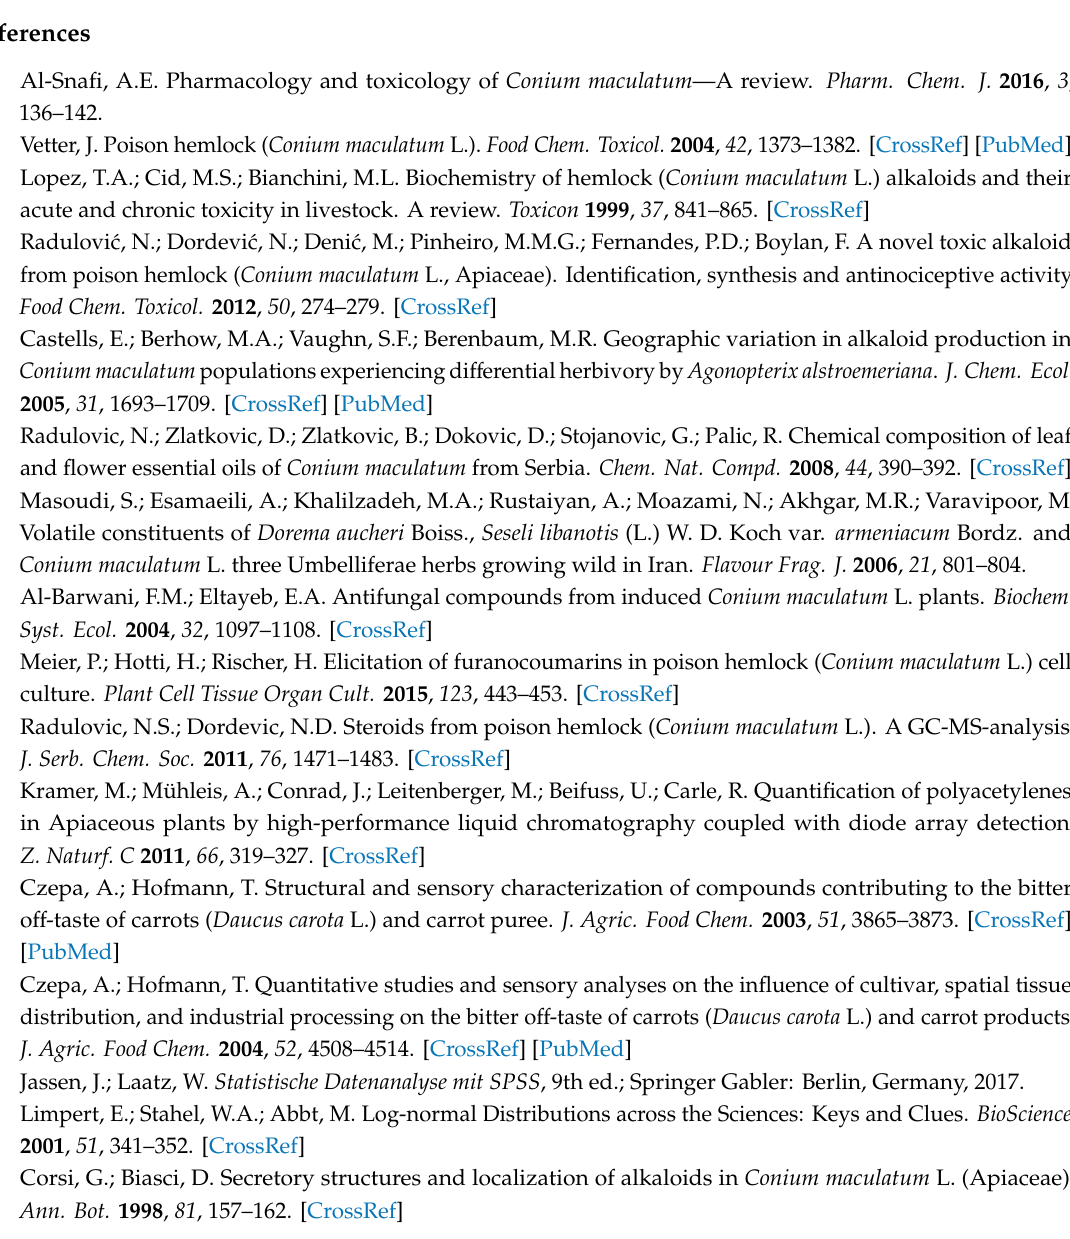
Table S1: Characteristics of secondary metabolite